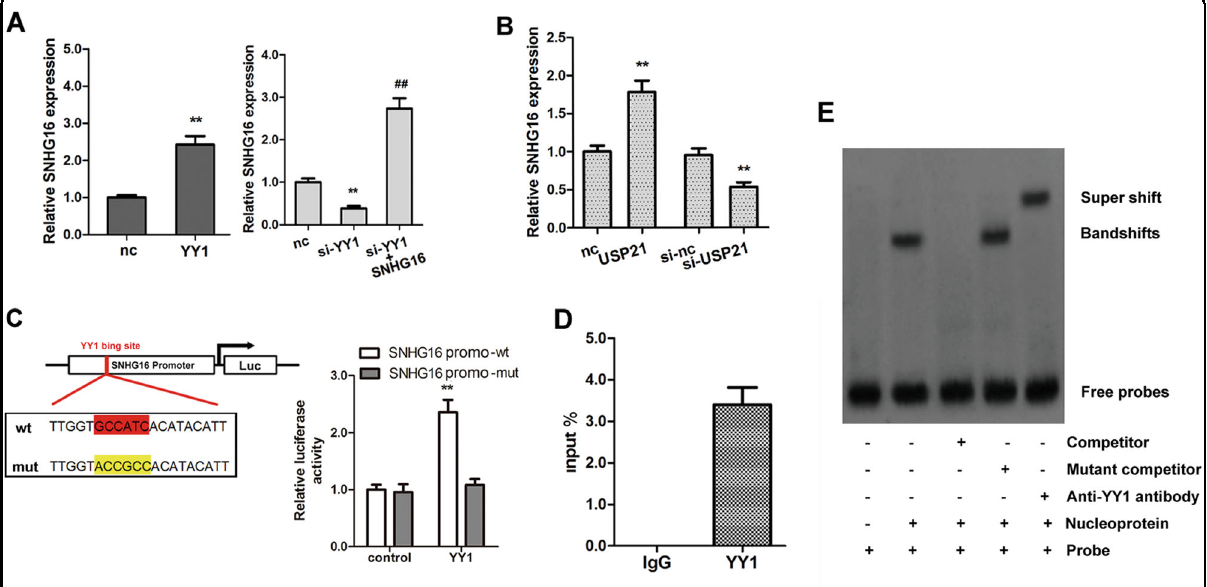
Fig. 6 YY1 transcriptionally activates SNHG16 via binding to its promoter region. a Relative SNHG16 expression was measured in A549 cells with overexpressed or silenced YY1. b Relative expression of SNHG16 after overexpression and silencing of USP21. c Dual luciferase assay results using the YY1 vector and either the wt or mutant SNHG16 promoter luciferase reporter vector. d Chromatin immunoprecipitation assay using an antibody against YY1; isolated DNA was ampli fi ed by PCR. e In vitro electrophoretic mobility shift assay using the nuclear extracts and the DNA probes containing the predicted YY1 binding sites. Data are shown as the mean ± SD ( n = 3). ** p < 0.01 vs. the corresponding control; ## p < 0.01 vs. the si- YY1